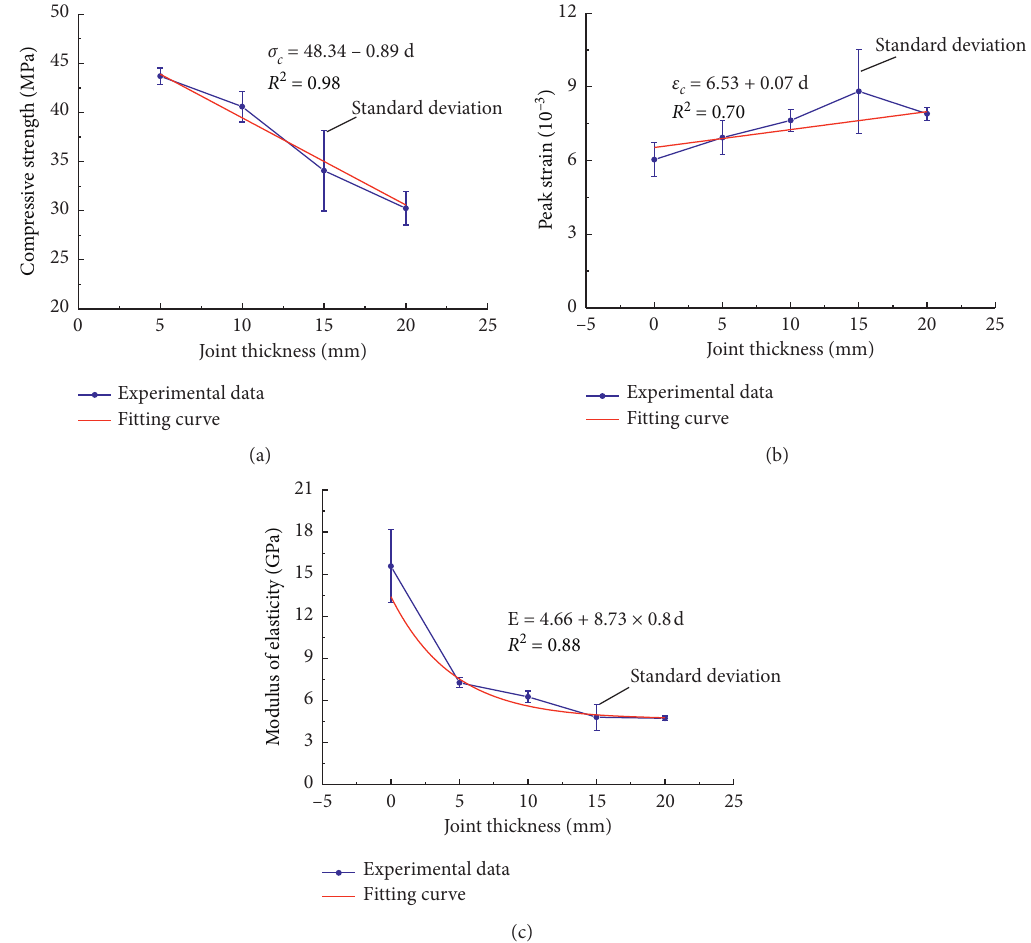
Figure 5: Relationship between the joint thickness and uniaxial compression mechanical parameters: (a) compressive strength, (b) peak strain, and (c) modulus of